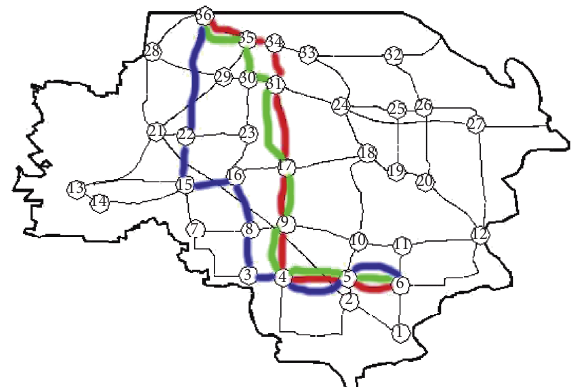
Figure 12: Pareto nondominated solutions between nodes starting at